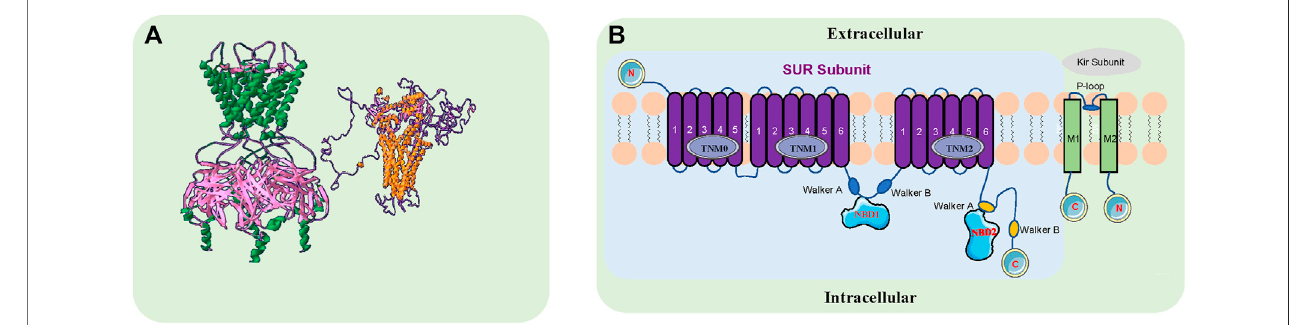
FIGURE 1 | The Structure of the K ATP Channel. (A) . K ATP channels are comprised of four sulfonylurea receptors (SURx) and four K + inward recti fi ers (Kir6. x) that assemble to form hetero-octameric protein complexes. The green and pink sections on the left represent the side view of the Kir6. x subunit, and the gold and purple sections on the right represent the side view of the SURx subunit. FASTA comes from NCBI, designed by www.swissmodel.com, Image designed by Swiss-Pdbviewer software. (B) . The pore-forming subunit Kir6. x (Kir6.1 and Kir6.2) has intracellular N- and C-termini and two transmembrane segments M1 and M2, encoded by KCNJ8 and KCNJ11, respectively. The modulatory subunit SURX (SUR1, SUR2A, SUR2B) consists of three groups of transmembrane domains (TMD0, TMD1 and TMD2) and extracellular N- and intracellular C-termini,encoded byABCC8 and ABCC9. There aretwointracellularnucleotide bindingfolds(NBD1 and NBD2) withinthe SUR subunit. ABCC8 and KCNJ11 are adjacent to each other on chromosome 11p15.1, with ABCC9 and KCNJ8 on chromosome 12P12.1.